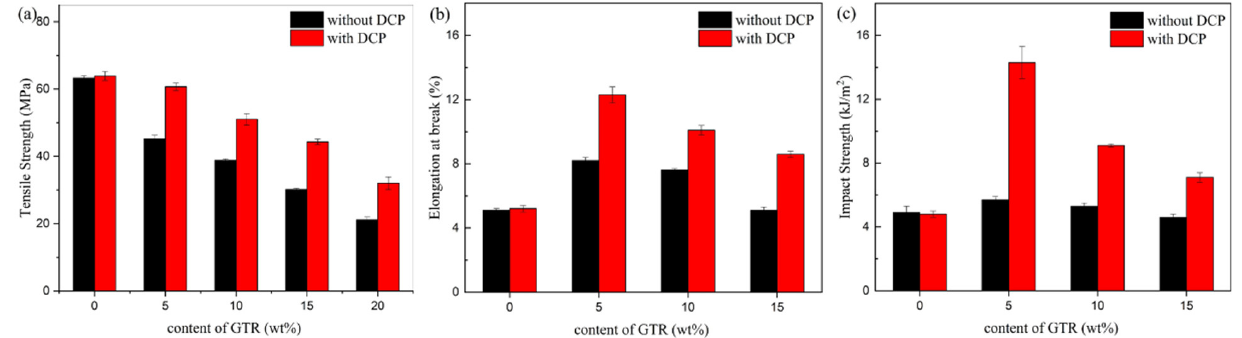
Figure 4. Mechanical properties of PLA as a function of GTR content with or without DCP: ( a ) Tensile strength. ( b ) Elongation at break. ( c ) Notched Izod impact strength.